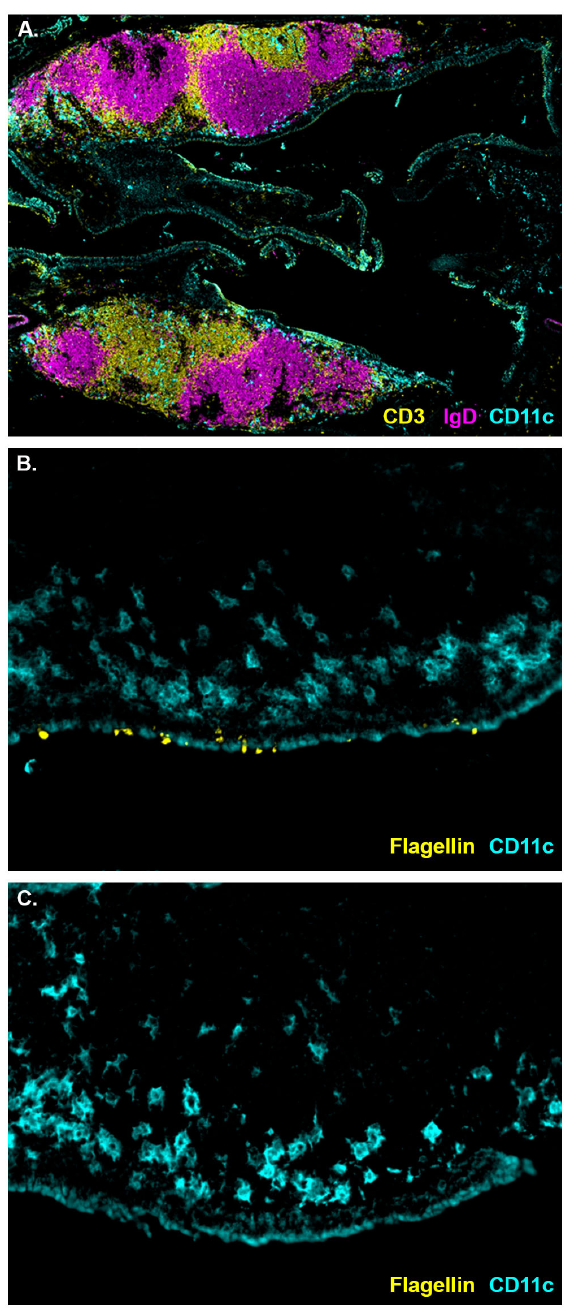
Figure 1. Cell populations and antigen sampling in the NALT of naïve mice. ( A ) Both NALT from one mouse showing IgD + cells (magenta), CD3 + cells (yellow), and CD11c + cells (cyan) (N = 4). ( B ) Luminal surface of the NALT bound by fluorescently labeled flagellin (yellow) two hours following i.n. instillation with CD11c + cells (cyan) in the subepithelial region (N = 4). ( C ) Luminal surface of the NALT two hours following i.n. instillation of fluorescently labeled flagellin (yellow) mixed with an excess of unlabelled flagellin with CD11c + cells (cyan) in the subepithelial region (N = 4). 2.2. Clustering of Naïve CD4 + T Cells in the NALT following Intranasal Immunization antigen presentation to and early activation of CD4 + T cells in draining lymph nodes